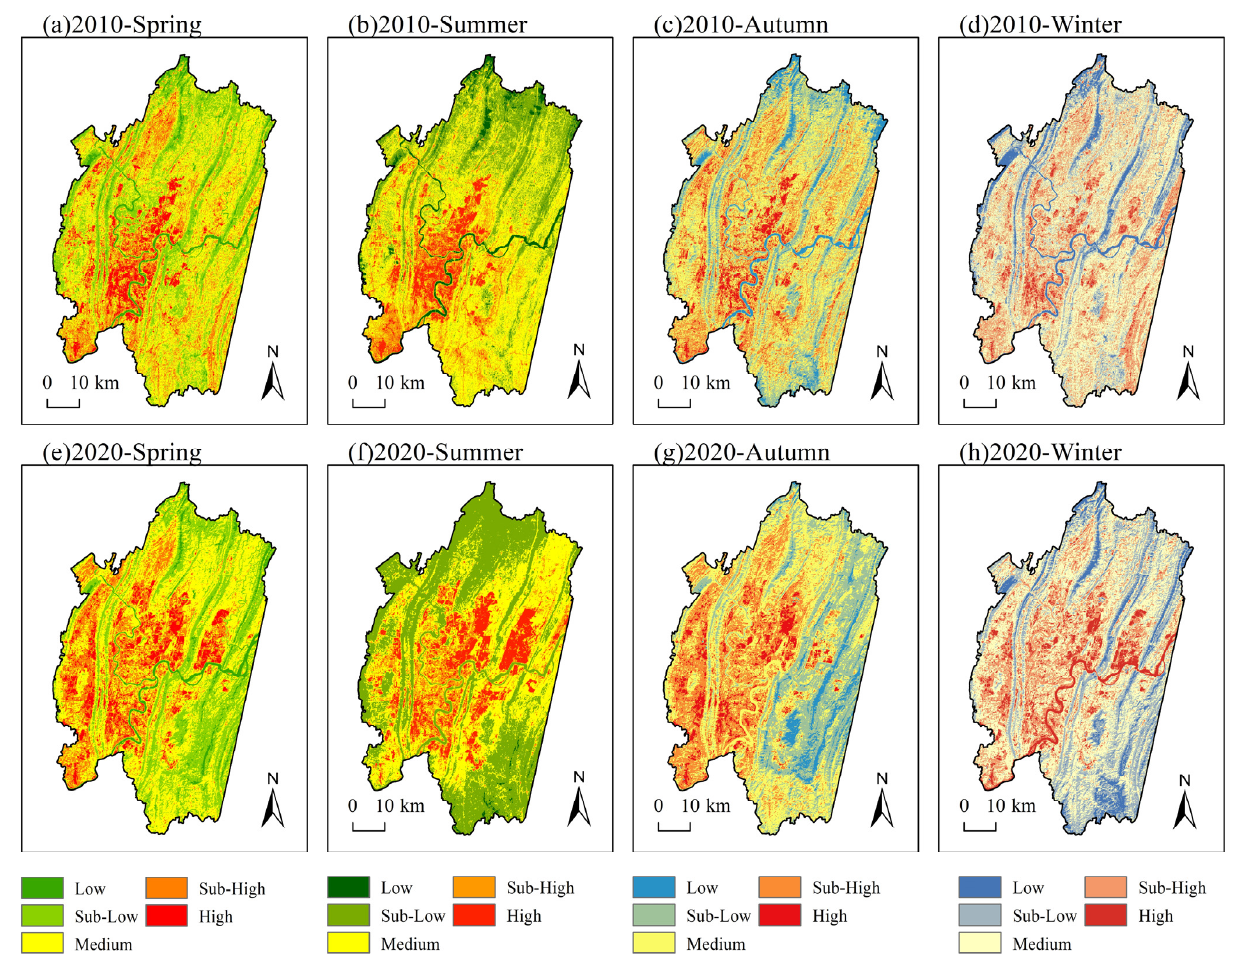
Figure 3. Spatial distribution of LST in all seasons from 2010 to